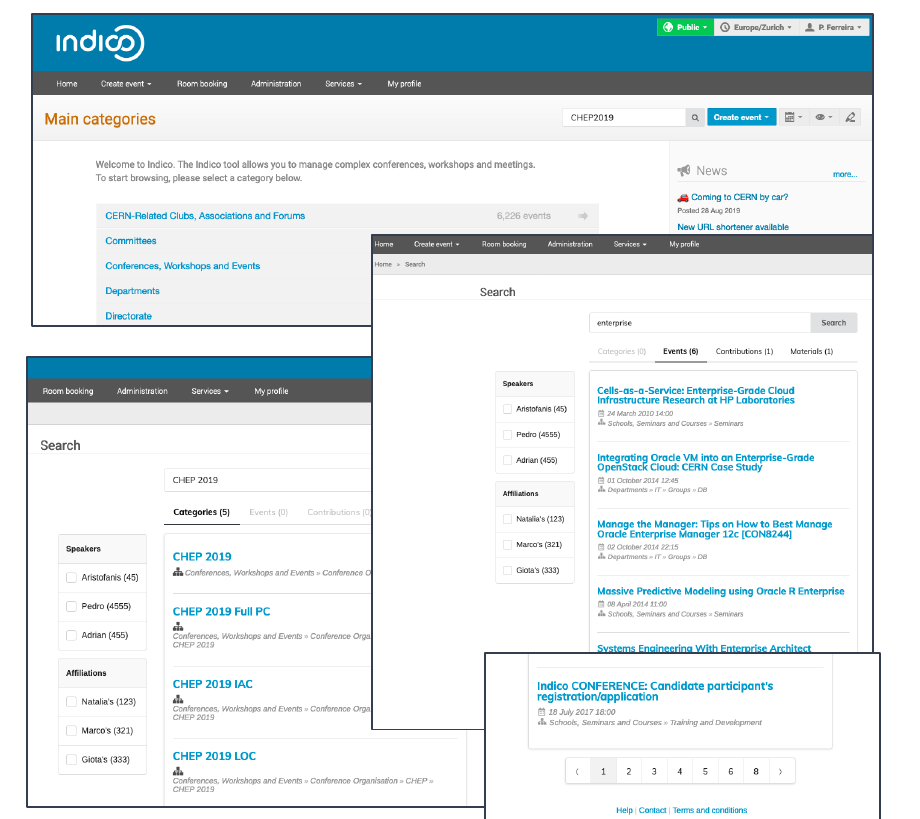
Figure 4. Indico’s search UI and search results